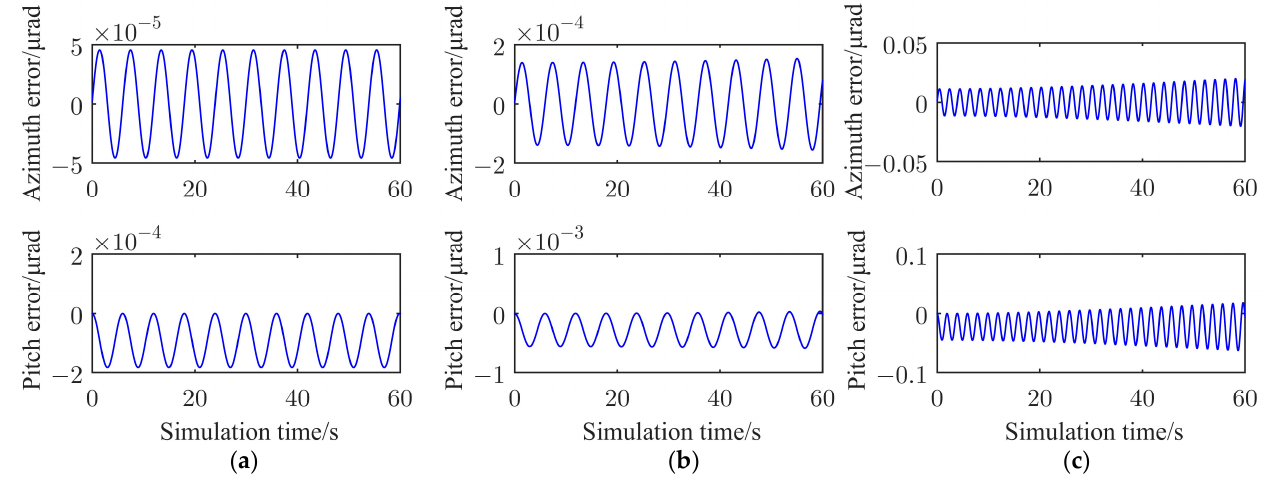
Figure 8. The error curve of the calculation of the indirect numerical calculation method in the reflector coordinate system O 41 X 41 Y 41 Z 41 . ( a ) a = 1 ◦ , ω = 60 ◦ /s; ( b ) a = 3 ◦ , ω = 60 ◦ /s; ( c ) a = 1 ◦ , ω = 180 ◦ /s.